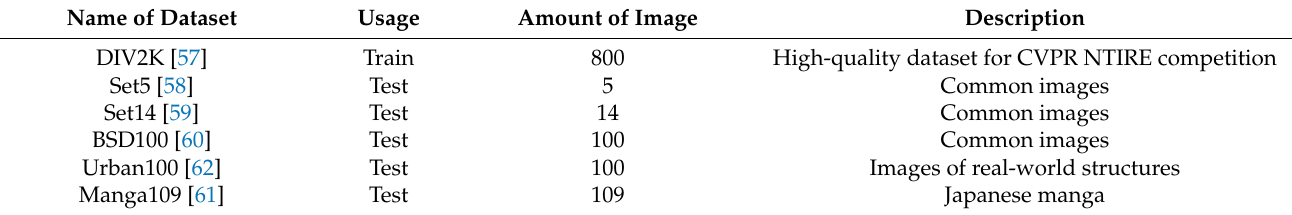
Table 1. Benchmark datasets for Single-Image Super-Resolution